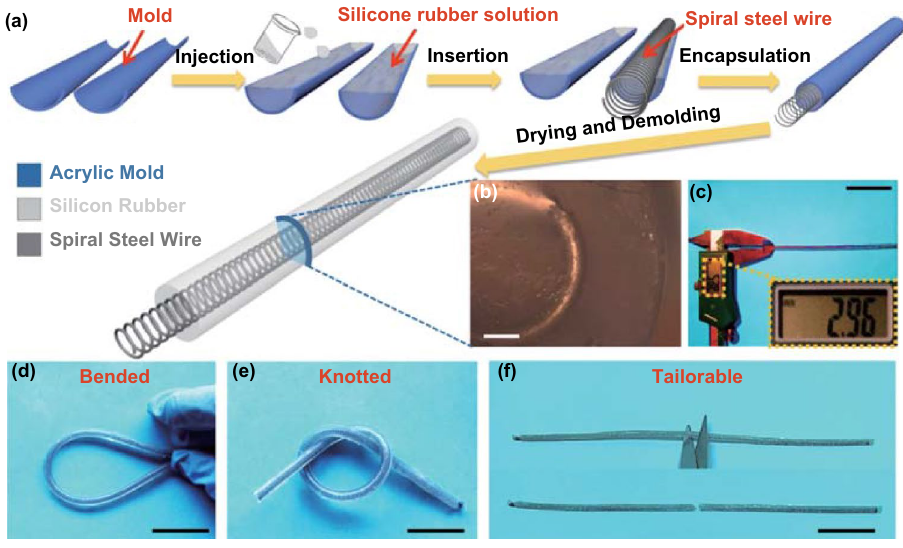
Fig. 1 Schematic illustration and mechanical behaviors of the spiral steel wire electrode based fiber‑shaped stretchable and tailorable triboelec‑ tric nanogenerator (FST–TENG). a Fabrication process of FST–TENG. b Cross‑sectional optical microscope image (scale bar: 500 μm). c Pho‑ tograph of the diameter measurement of FST–TENG (scale bar: 2 cm). Photograph of the FST–TENG at different states: d bended, e knotted, and f tailorable state (scale bars: 3